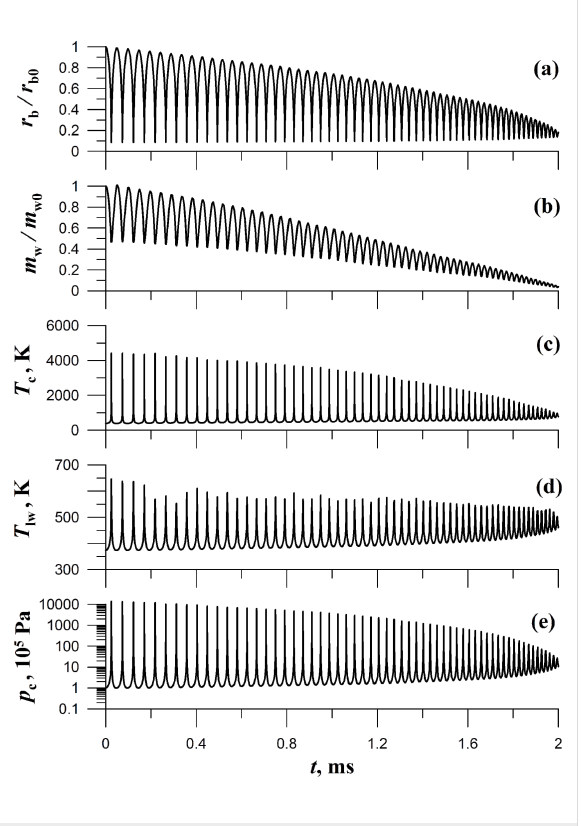
Figure 4: Time dependencies r b / r b0 , m w / m w0 , T c , T lw , and p c in a pulsating cavitation bubble. Initial parameters are the bubble radius r b0 = 0.1 cm, the pressure inside the bubble p 0 = 10 5 Pa, the vapor temperature T 0 = 373 K. The pressure in the liquid far from the bubble is p ∞ = 15 p 0